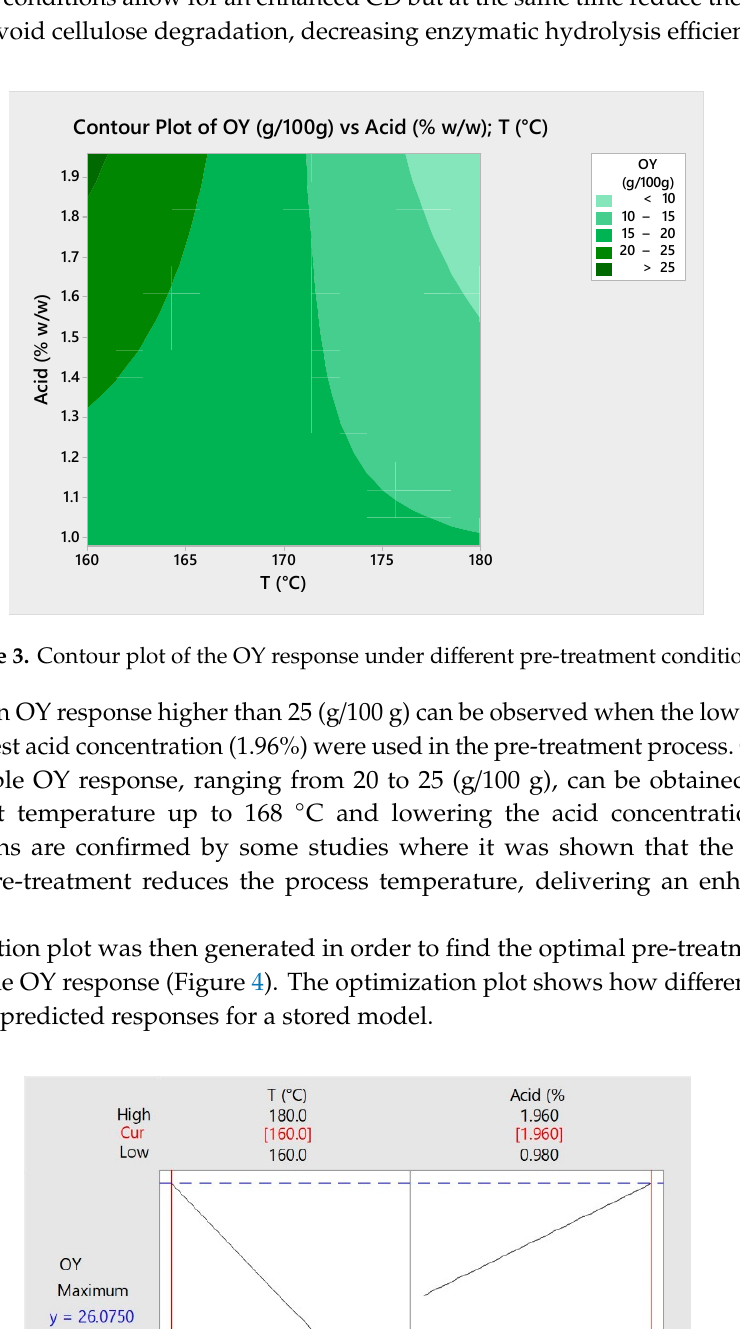
Figure 4. The optimization plot shows the conditions needed to maximize the OY. The vertical red lines on the graph represent the current factors’ (temperature and acid concentration) settings.